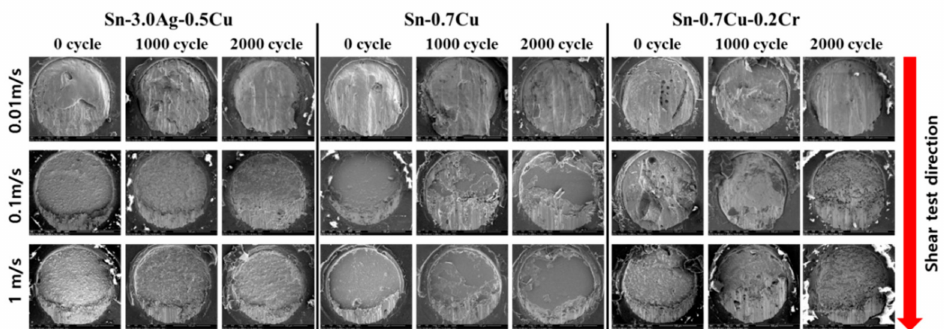
Figure 7. Fracture surfaces of the solder joints under various shear speeds.